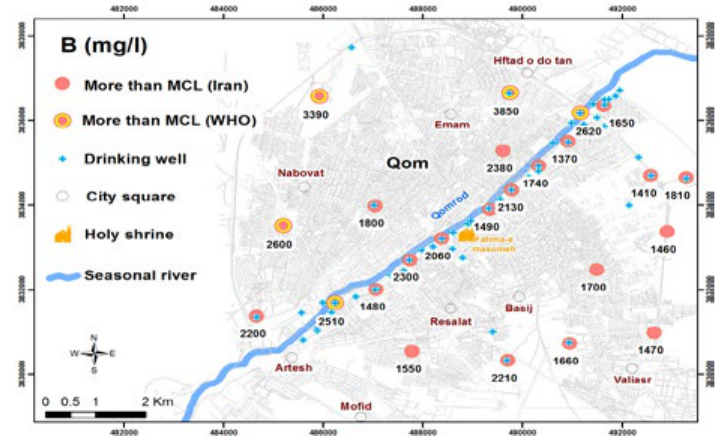
Fig. 6. Boron concentration in Groundwater of Qom urban